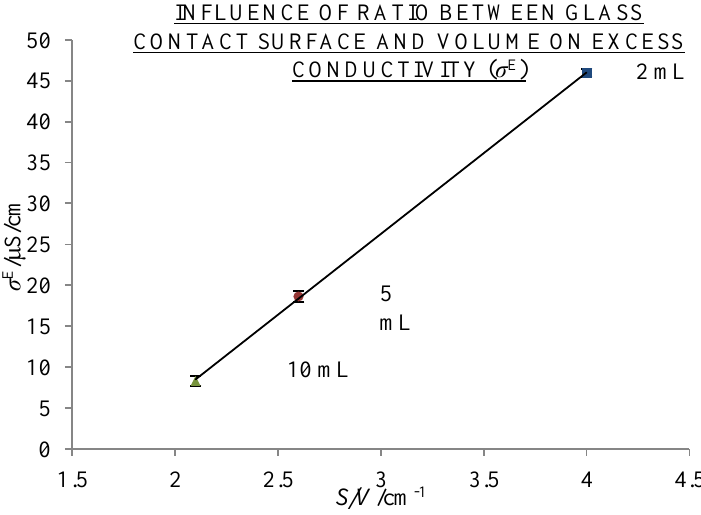
Figure 4. Influence of the ratio of the glass contact surface and the volume, S/V , on average σ E with SE intervals, measured at 25 °C and 1000 Hz, aged for 370 days in 2 mL (blue), 5 mL (red) and 10 mL (green) volumes of 20-mL flasks; number of replicate solutions, N (/): 2 mL (8), 5 mL (10), 10 mL (10). The abscissa starts at 1.5 cm −1 .